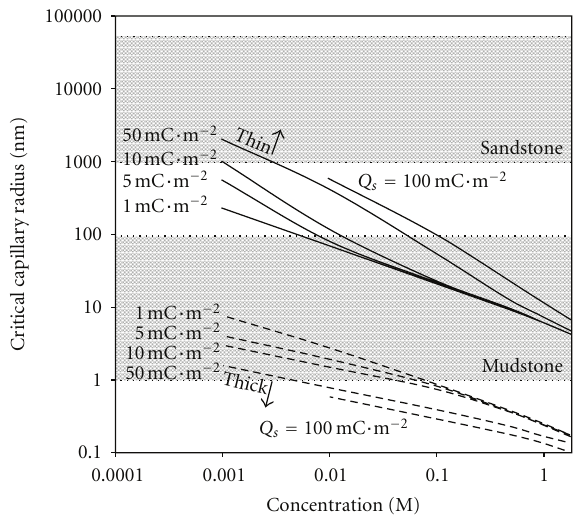
Figure 7: Critical capillary radius (determined from Figure 6) above which the thin double-layer approximation is valid (solid lines) and below which the thick double-layer assumption is valid (dashed lines), as a function of electrolyte concentration. Curves correspond to surface charge values of 1, 5, 10, 50, and 100 mC · m − 2 . Also shown are typical ranges of pore and pore-throat radii in sandstones and mudstones